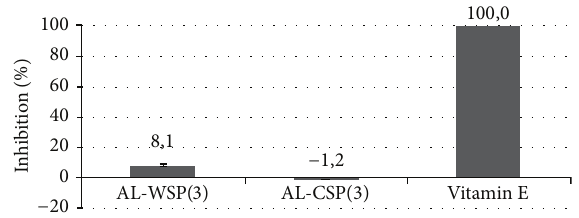
Figure 4: Antioxidant activity of water-soluble (AL-WSP3) and chelating-soluble (AL-WSP3)